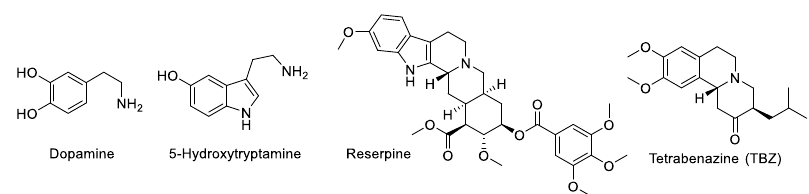
Figure 1. The structures of dopamine, 5-hydroxytryptamine, reserpine, and tetrabenazine (TBZ).